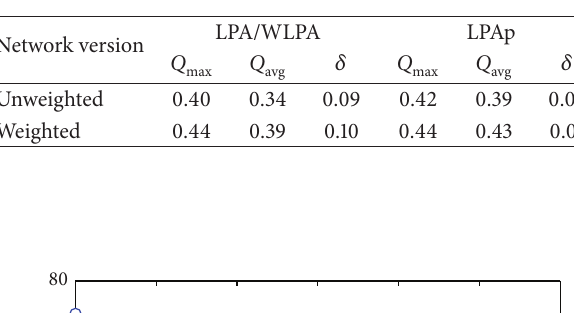
Table 4: Comparisons between LPA, WLPA, and LPAp on unweighted and weighted club networks.